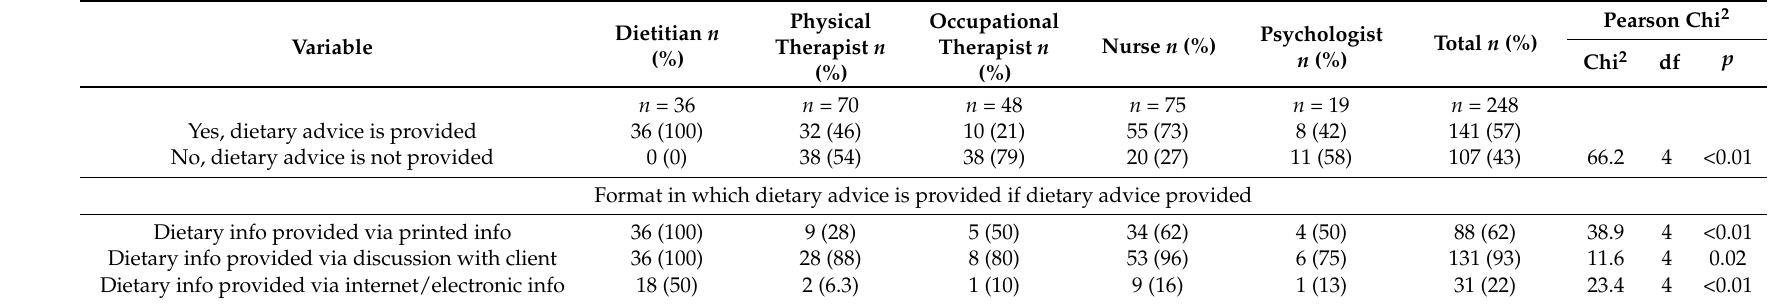
Table 3. Allied health professionals reported practices related to provision of dietary advice for weight management.